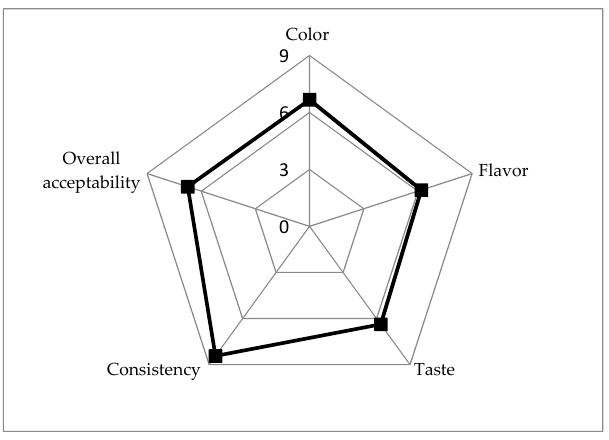
Figure 2. Hedonic test results for sensory analysis of SOFB.